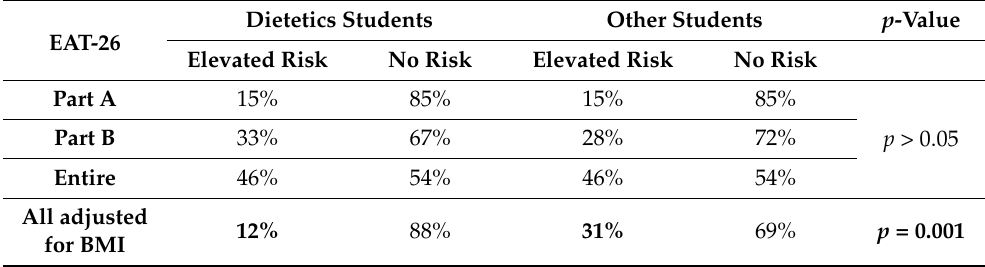
Table 4. Summary of eating disorder risk estimation (EAT-26) ( n =